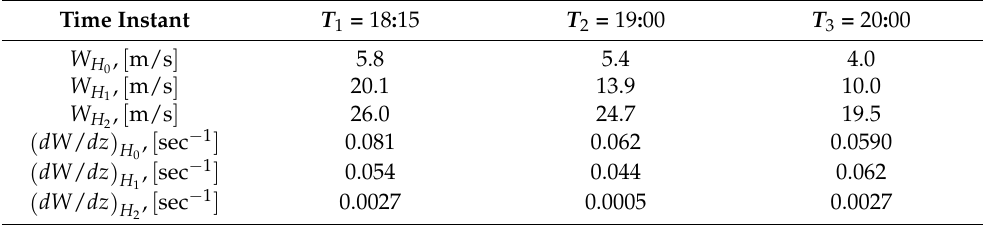
Figure 7. Wind magnitude profiles for selected time extracts from MRAMS data at the Jezero crater site. With ( a ) the west (U) and north (V) components of wind, ( b ) the wind direction, ( c ) the wind magnitude, ( d ) the vertical gradient in horizontal wind for each time. Table 2. Characteristics of wind